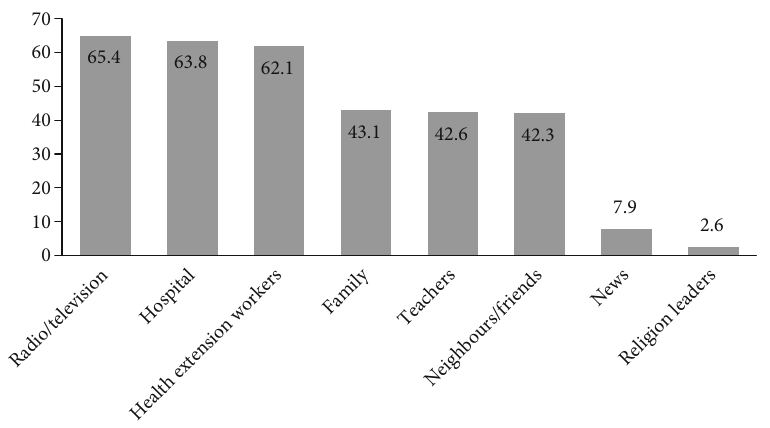
Figure 1: Sources of information about malaria as reported by respondents in Mekaneeyesus hospital,